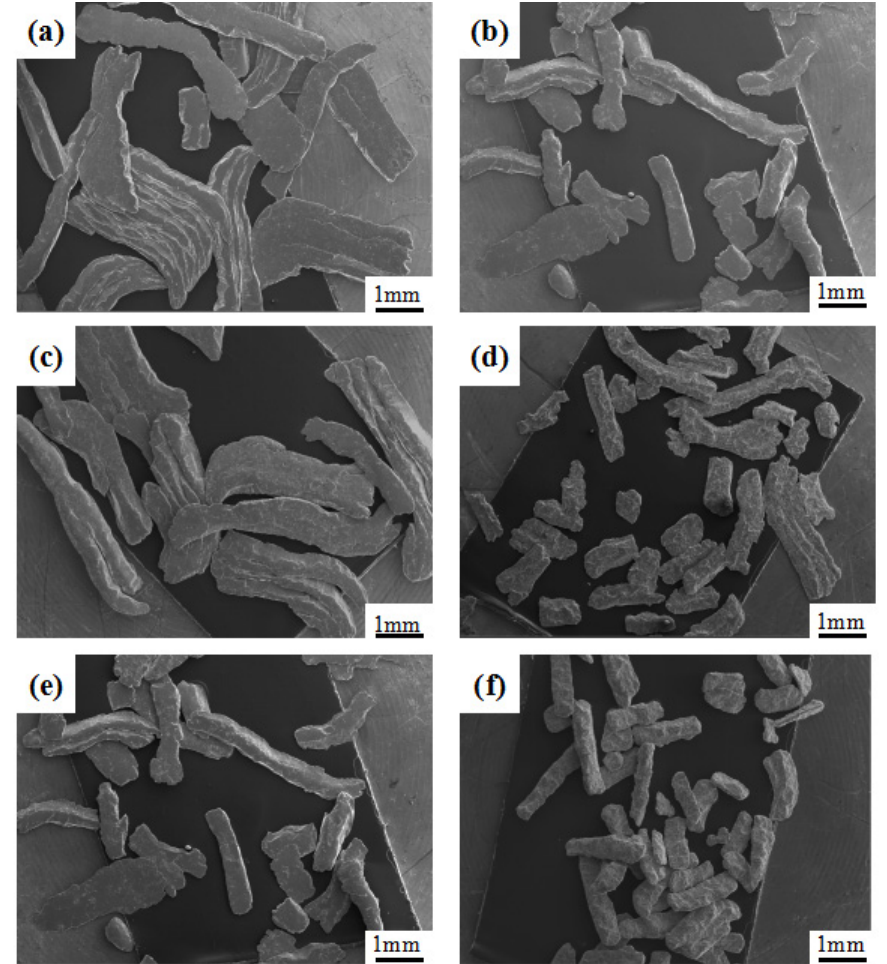
Figure 4. Morphologies of composite powders with di ff erent TiB 2 additions after milling for 30 h, 70 h and 110 h: ( a ) 30 h, 2.5 wt %, ( b ) 30 h, 10 wt %, ( c ) 70 h, 2.5 wt %, ( d ) 70 h, 10 wt %, ( e ) 110 h, 2.5 wt %, ( f ) 110 h, 10 wt %.